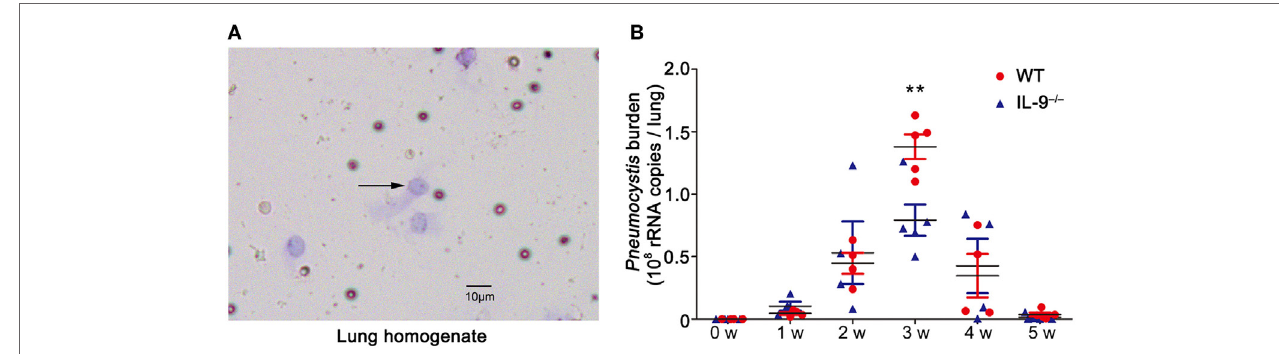
FigUre 1 | IL-9 deficiency reduced the Pneumocystis burden. The mice were infected with 10 6 Pneumocystis organisms and were sacrificed at weeks 1, 2, 3, 4, and 5. (a) The lung from mice was homogenized and smeared quickly for Diff-Quick stain. The black arrow indicates Pneumocystis murina asci (200 × ). (B) The Pneumocystis burden was detected by TaqMan quantitative PCR. The uninfected mice had no detectable Pneumocystis burden. The results were from three experiments using three to five mice per group per time point. ** P < 0.01 compared to WT group at the same time point by a two-way ANOVA followed by a Bonferroni multiple comparison